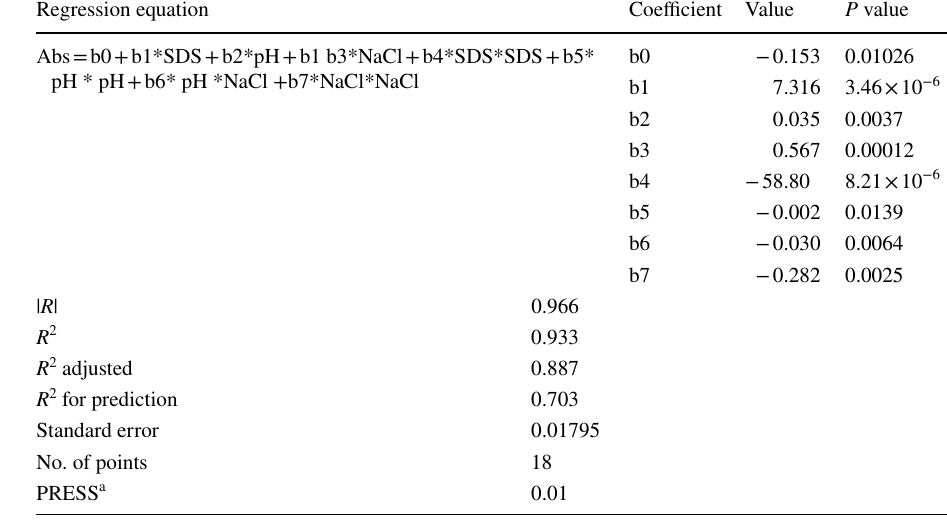
a Prediction error sum